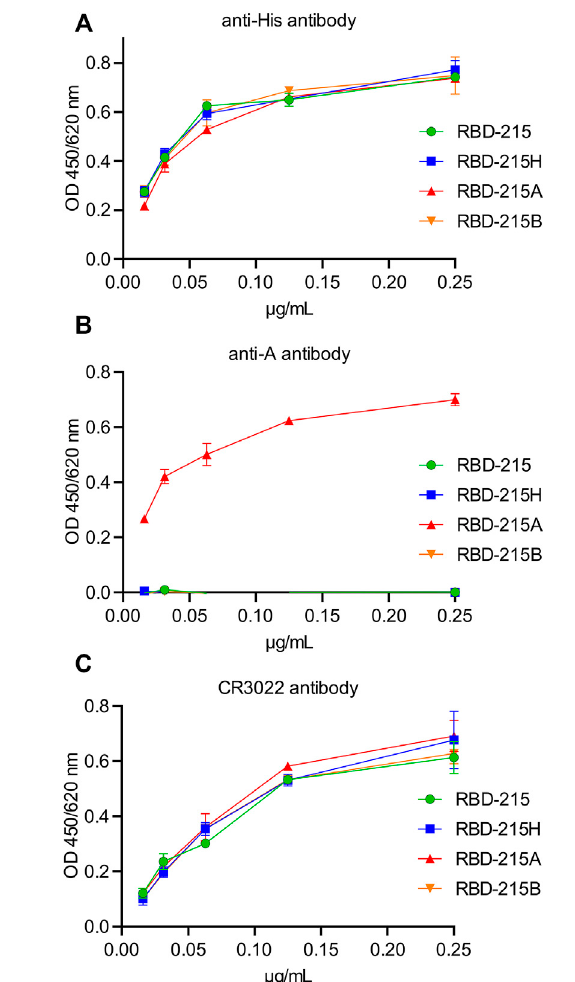
FIGURE 5 | The anti-A antibody speci fi cally reacts with RBD-215 carrying blood group A antigen structures. IMAC-puri fi ed RBD-215 variants were coated and ELISA was carried out with different concentrations of (A) antibodies against the His-tag, (B) the 3-3A antibody against anti-blood group A antigen structures and (C) CR3022, a conformation dependent anti- RBD antibody. Values represent the mean ± SD ( n (cid:1) 3).